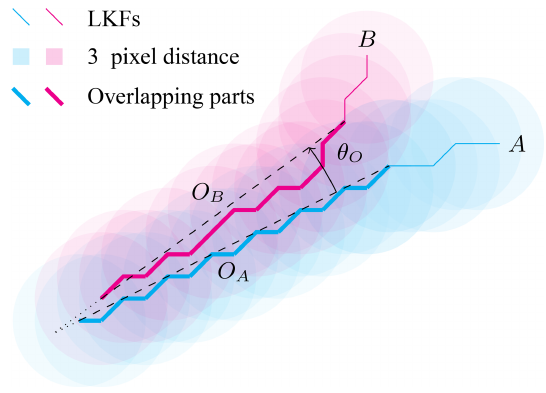
Figure 4. Illustration of overlap between two LKFs A and B